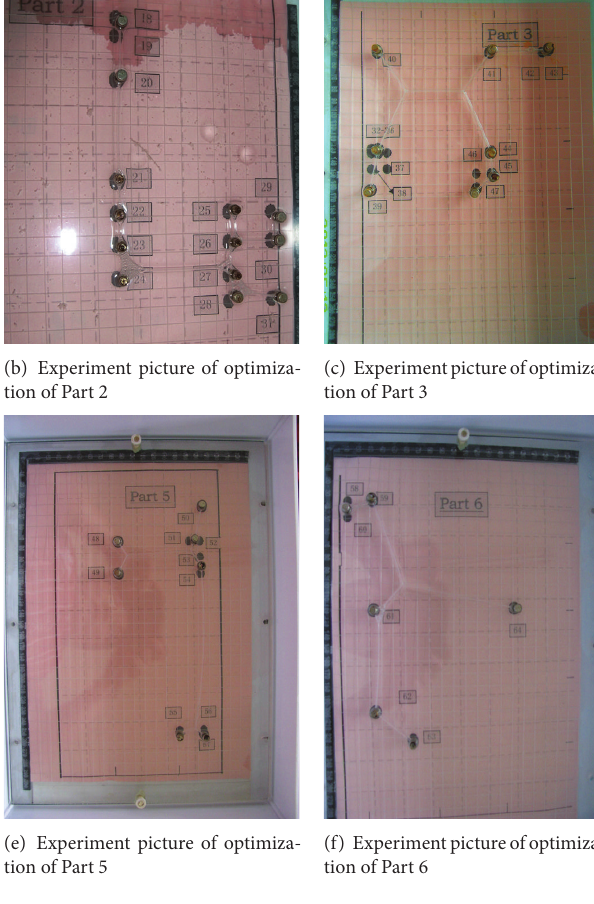
Figure 11: Experiment